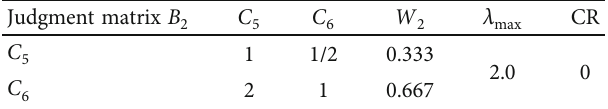
Table 14: Judgment matrix of mining technical indicators.